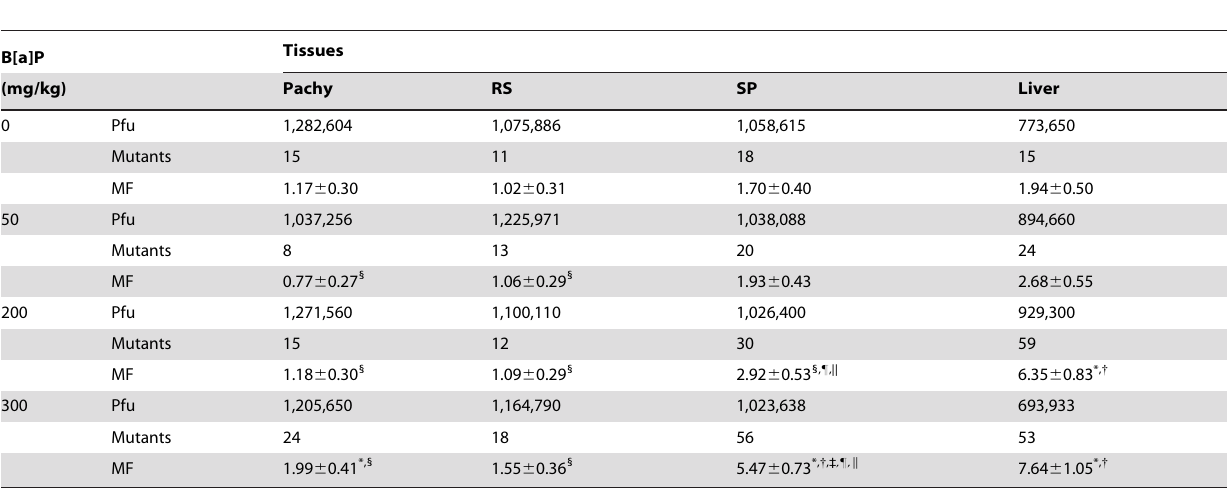
Table 3. Mutant frequencies (mean 6 SE 6 10 2 5 ) in different cell types and liver tissue from mice treated with B[a]P at 60 days